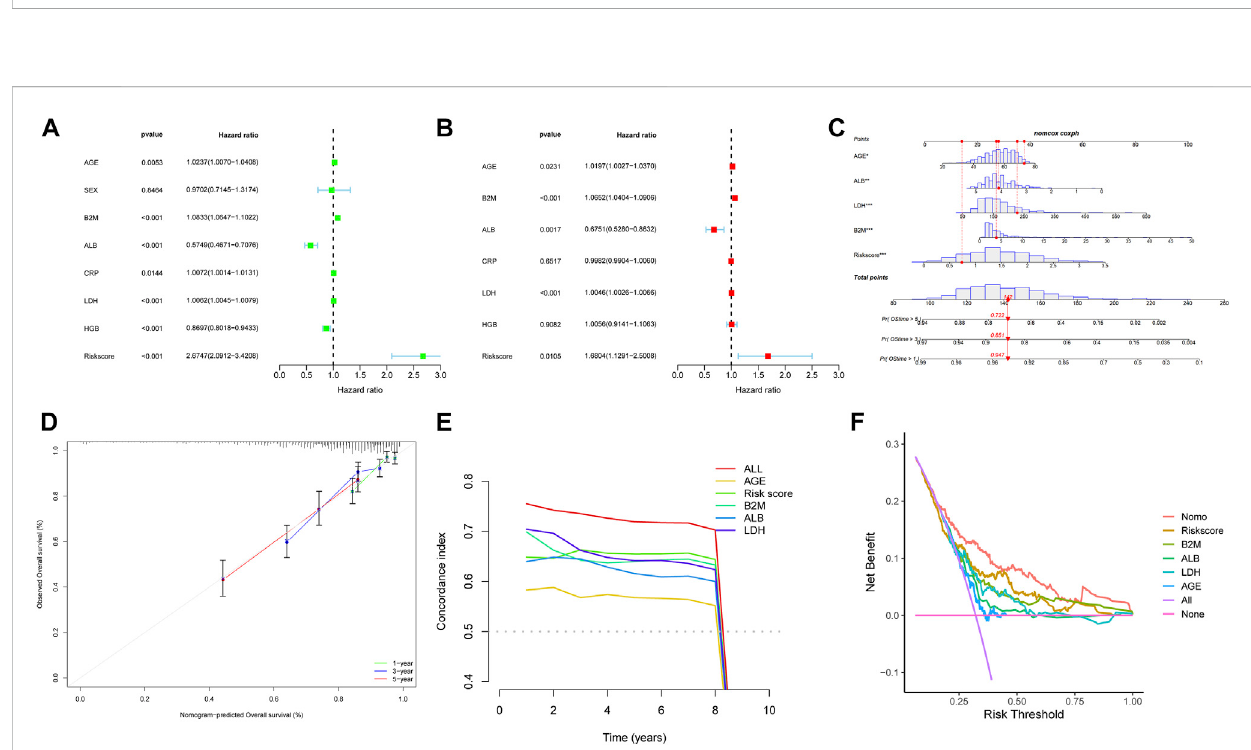
FIGURE 6 Nomogram construction based on the eight-gene signature and prognostic value of genes. Forest plot of univariate (A) and multivariate (B) Cox regressionanalysisof the clinical features in GSE24080. (C) Nomogram of risk score and other clinical factors for predicting MM1-, 3-, and 5-year overall survival in GSE24080. (D) The calibration plot (D) , C-index (E) , and DCA curves (F) of the nomogram in